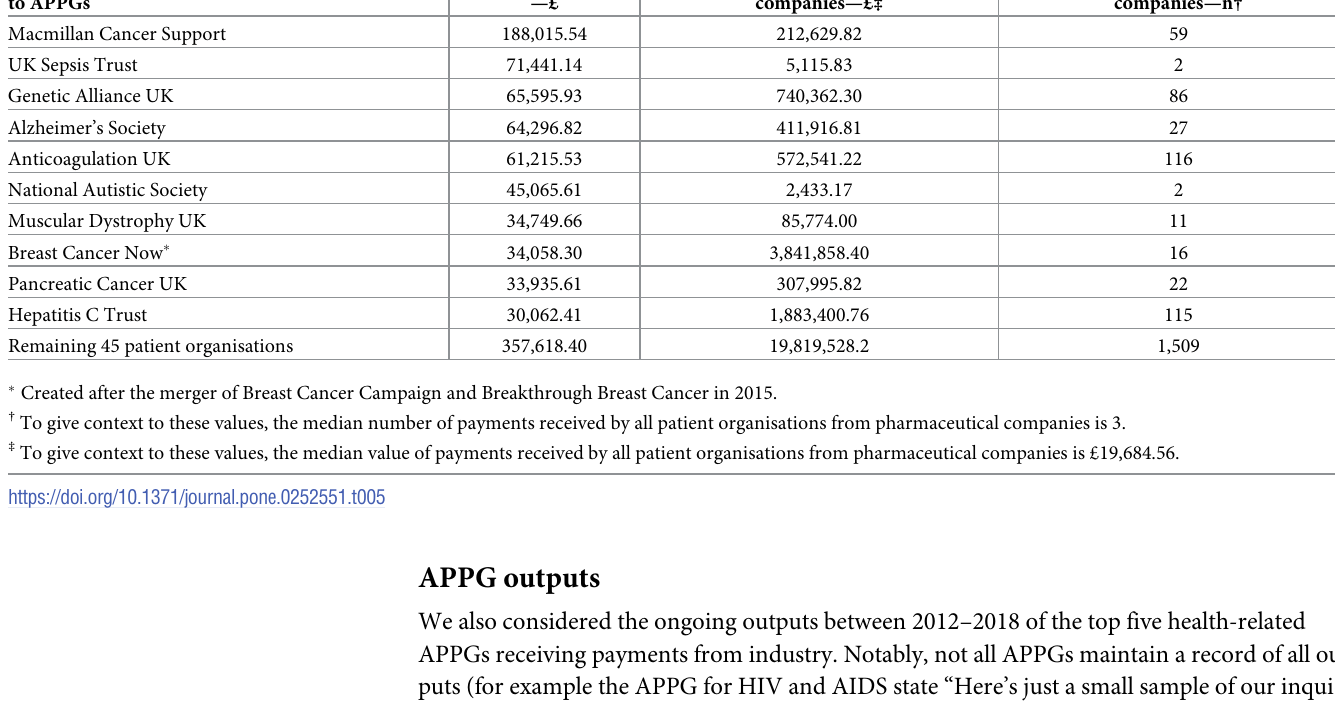
Table 5. Top 10 pharmaceutical-industry funded patient organisations by value of payments provided to APPGs. Top 10 patient organisations by value of payments to APPGs